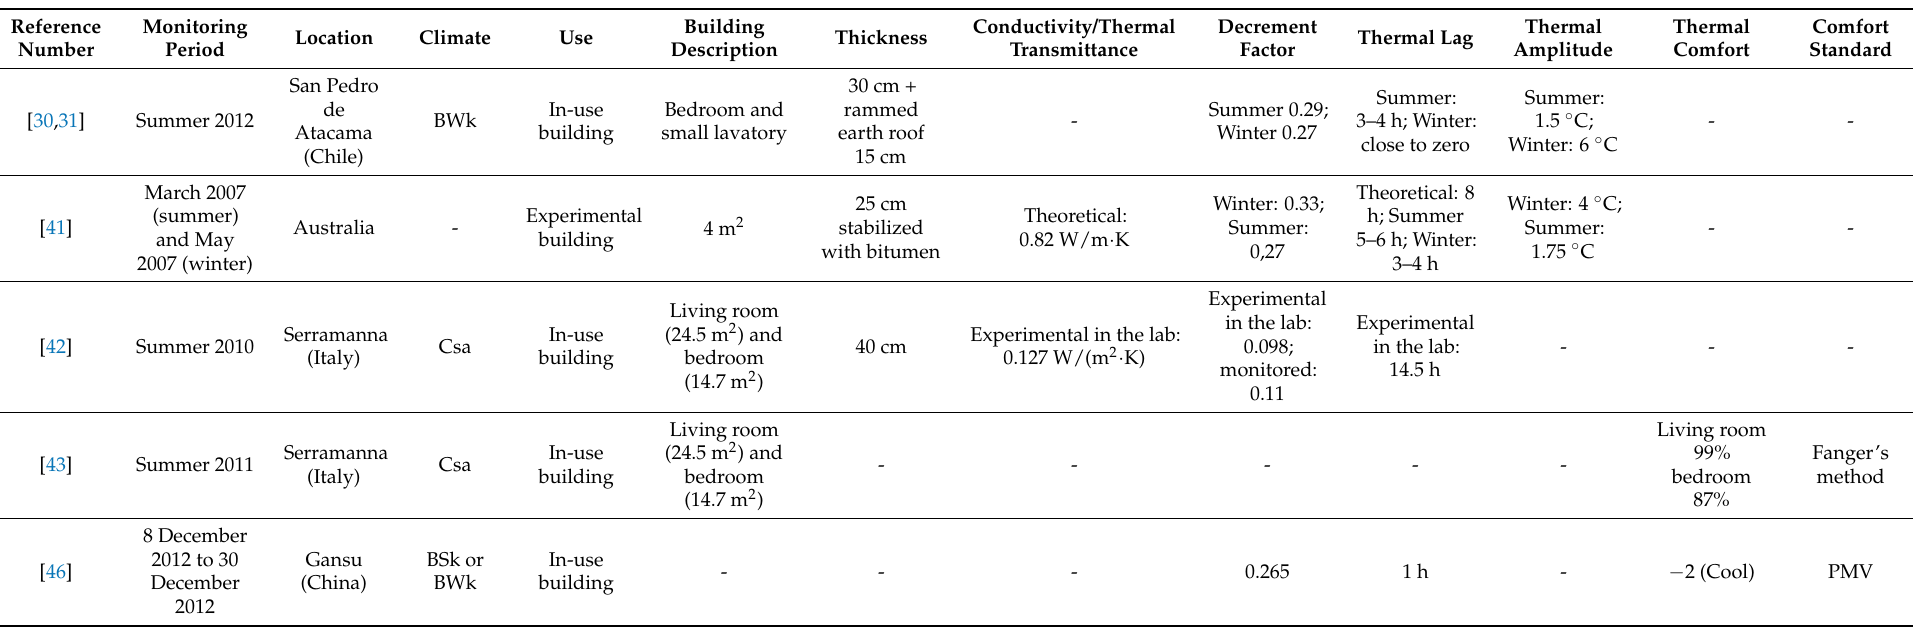
Table 11. Building characteristics and thermal performance of the adobe monitored